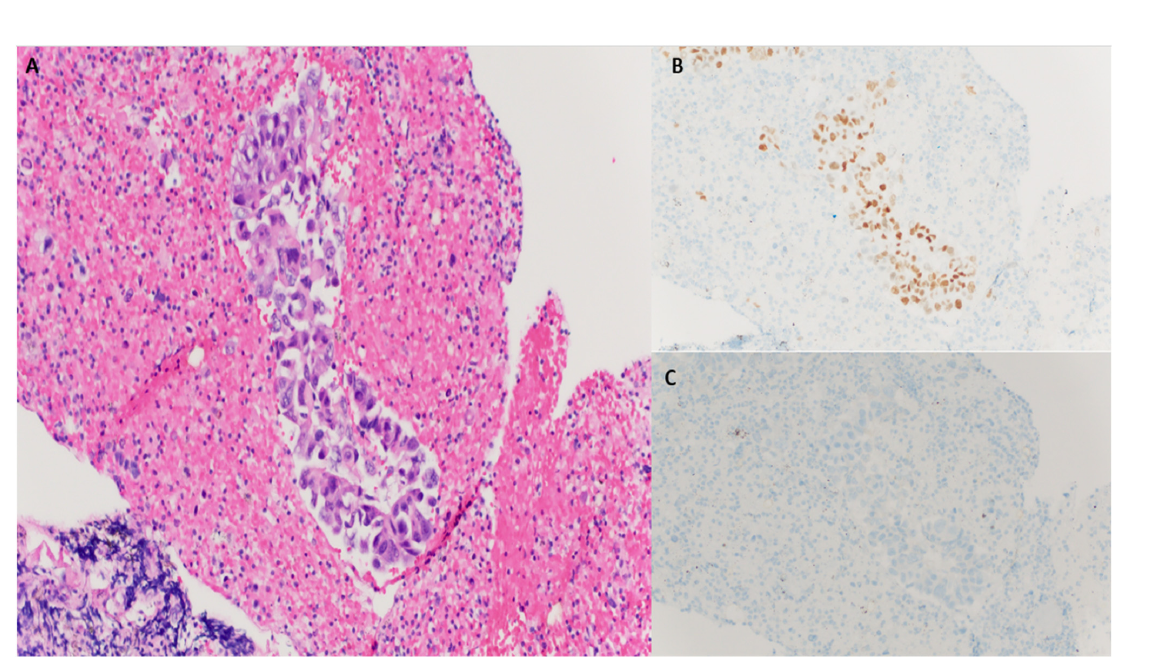
Figure 2. ( A ), H&E 20×, tumor cells forming incomplete lumina with hyperchromatic nuclei; ( B ) Strong nuclear staining of tumor cells with TTF1; ( C ) Tumor cells are negatively stained for P40. Table 1. Oncology history and treatment